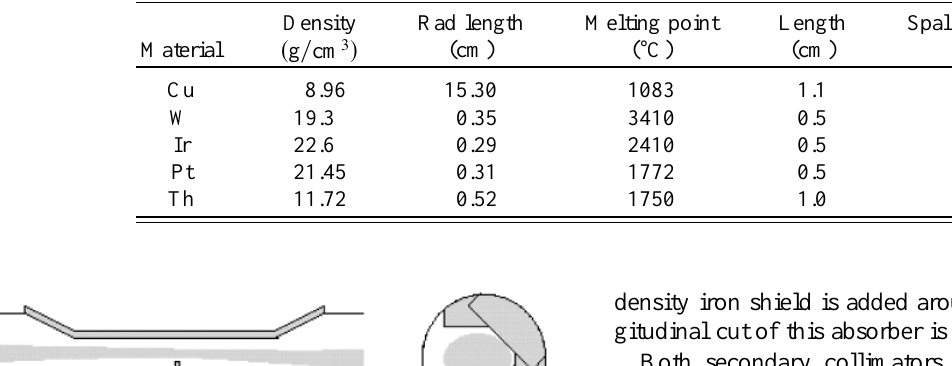
TABLE II. Comparison of different scraper materials. The neutron production has been ob- tained by simulation taking a thin target with the correct thickness to produce d p (cid:1) p 0 (cid:1) 2 0.01 .